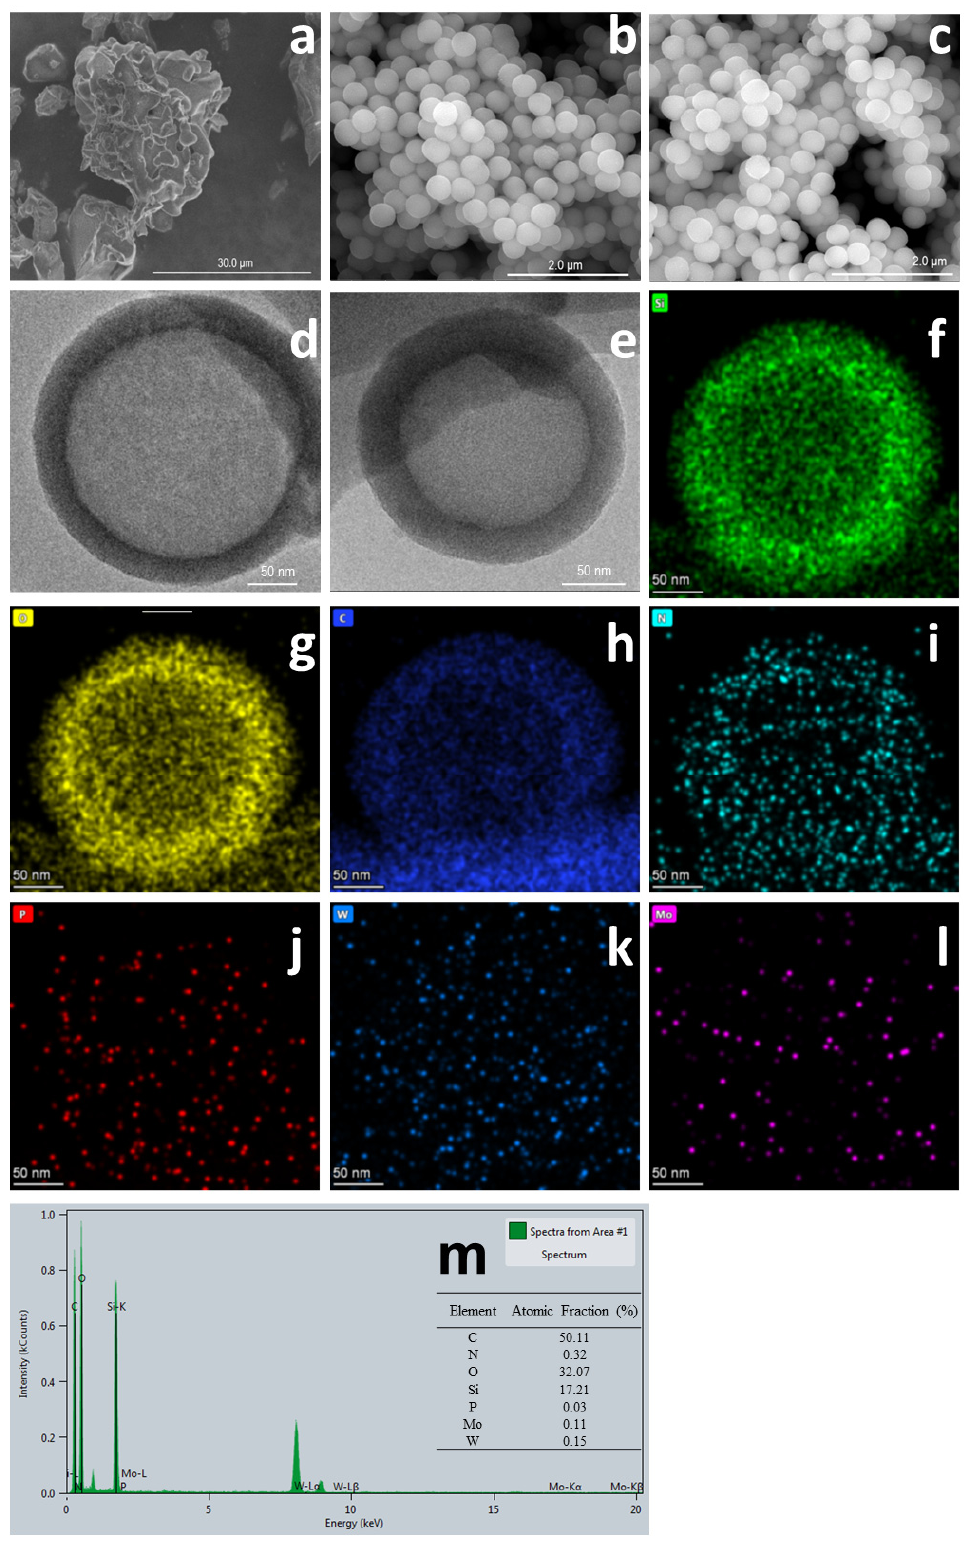
Figure 5. SEM images of PW 2 Mo 2 ( a ), HPMOS ( b ), and PW 2 Mo 2 @HPMOS ( c ). TEM images of HPMOS ( d ) and PW 2 Mo 2 @HPMOS ( e ). Mapping image of PW 2 Mo 2 @HPMOS ( f – l ). EDX spectrum of PW 2 Mo 2 @HPMOS ( m ). 3.2. Desulfurization E ffi ciency Catalyzed by PW 2 Mo 2 @HPMOS Nanoreactor